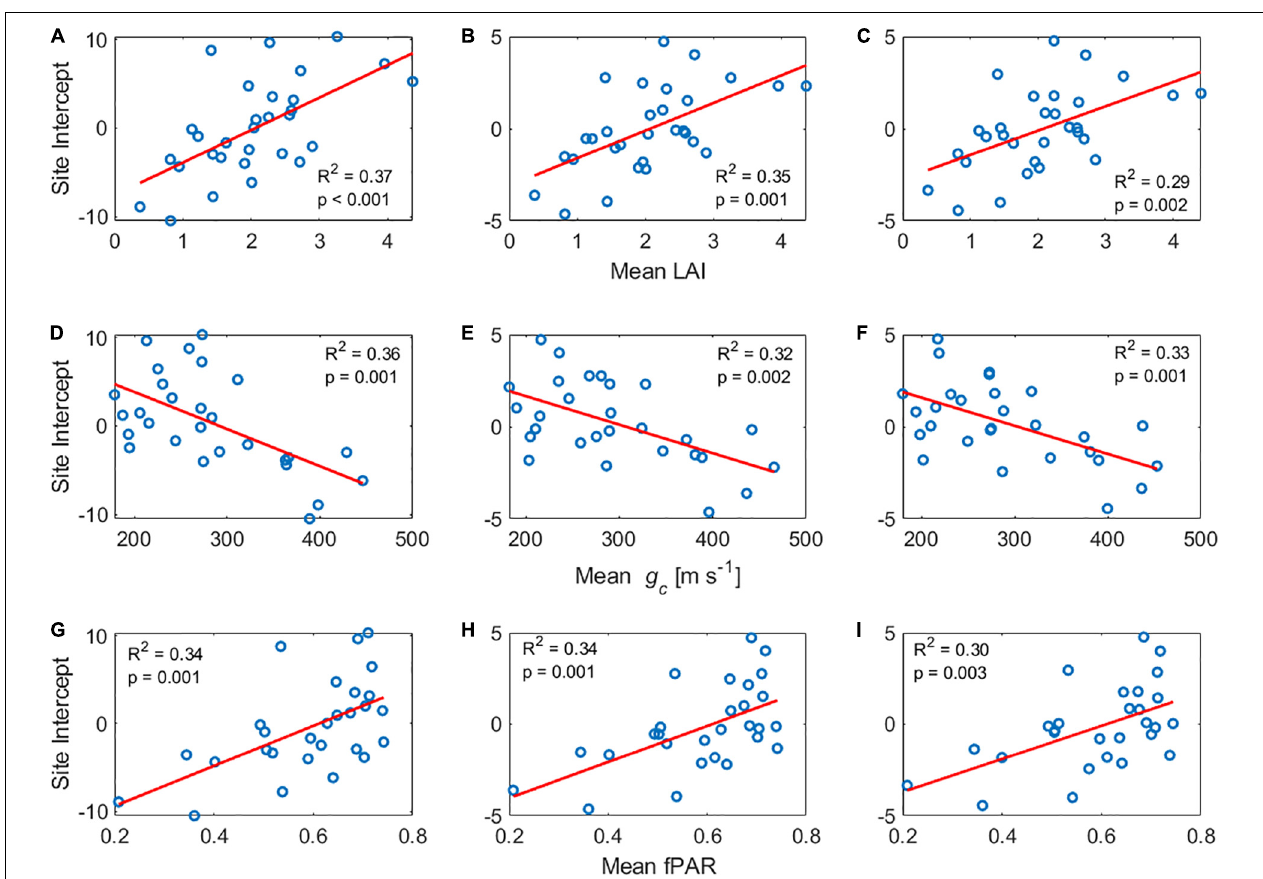
FIGURE 7 | Site-level intercept estimated by LME vs. Mean LAI for (A) Hourly, (B) Daily, and (C) Weekly timescales. Site-level intercept estimated by LME vs. Mean g c for (D) Hourly, (E) Daily, and (F) Weekly timescales. Site-level intercept estimated by LME vs. Mean fPAR for (G) Hourly, (H) Daily, and (I) Weekly timescales. The red line represents the linear regression fit.